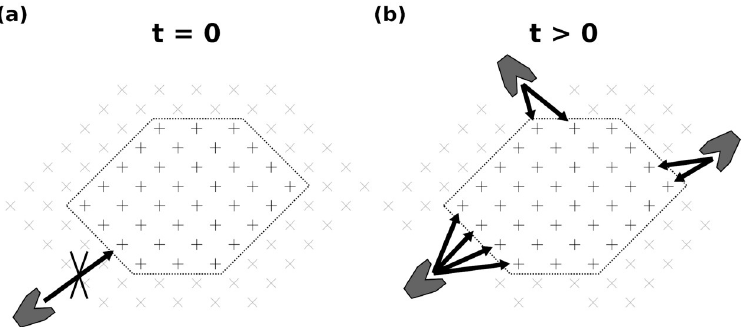
Fig 2. Sketch (top-down view) of the accessibility of polymer bonds depending on their position within the substrate and its digestion state. (a) Beginning of the simulation: the outer layer (gray crosses, here made entirely of hemicellulose) does not contain any gaps. None of the cellulose bonds (black crosses) are accessible for digestion by enzymes (dark gray polygons). Only the hemicellulose bonds are digestible. (b) Later stage of the simulation: some of the hemicellulose within the outer shell has been digested. The cellulose bonds highlighted by arrows are now accessible for digestion.